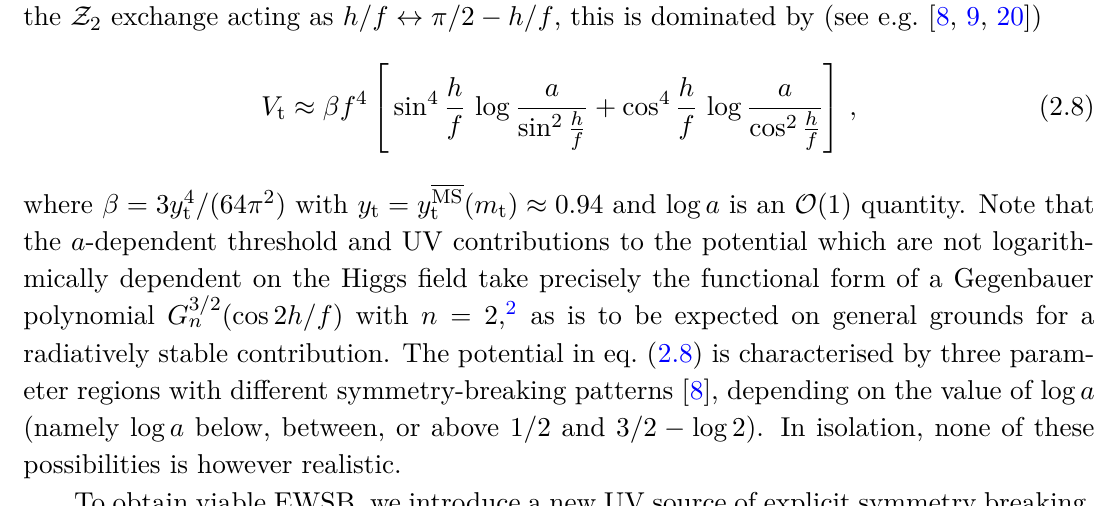
Figure 1 . Full Gegenbauer’s Twin potential V = V t + V ( n ) lines show the top-sector component V t . Parameters are fixed so as to reproduce the physical Higgs mass and vev in the first